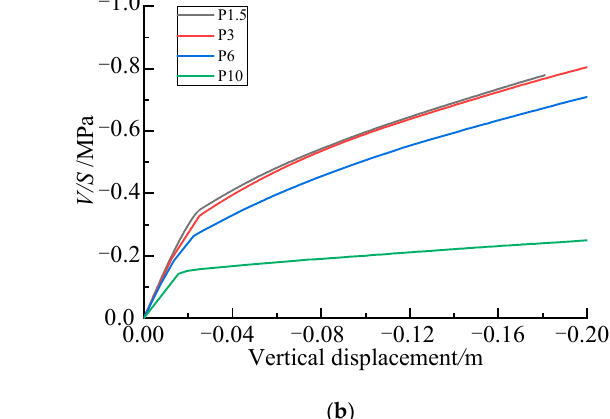
Figure 15. Variation of displacement and stress with depth. ( a ) Indentation displacement–depth curves; ( b ) Stress–depth curves.